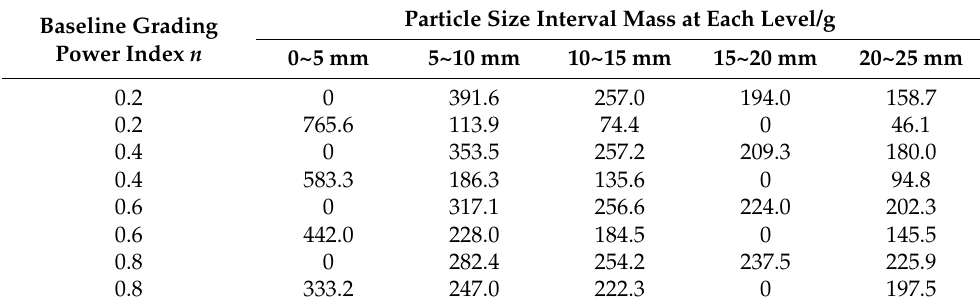
Table 2. Particle size interval mass distribution under intermittent